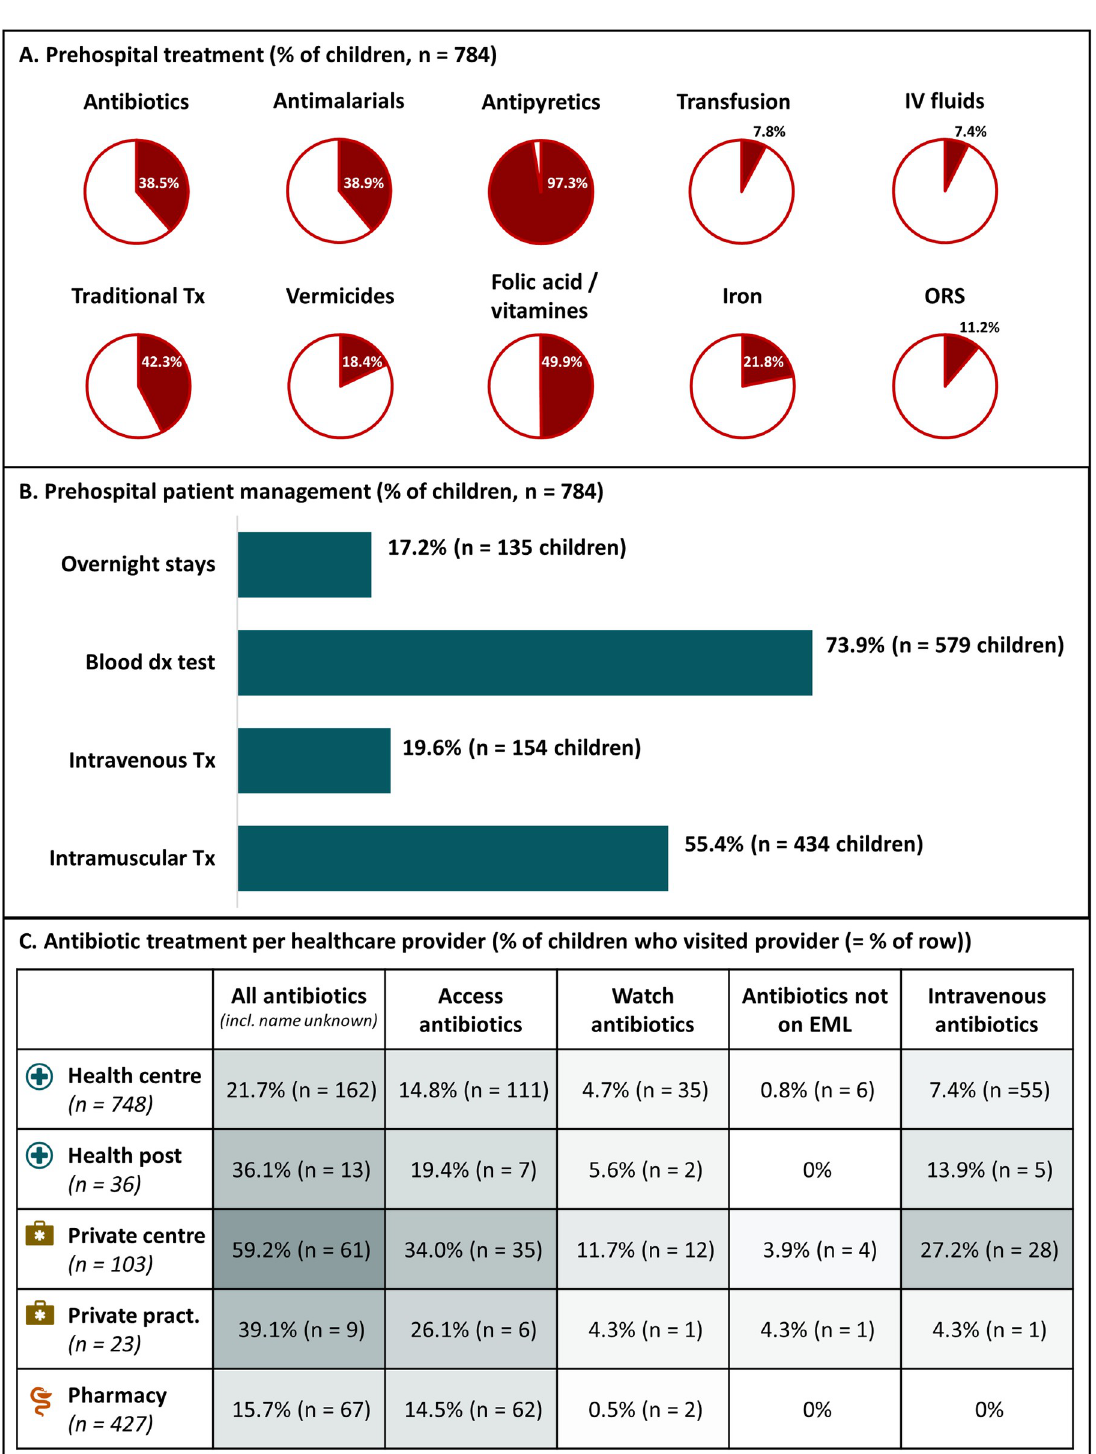
PLOS NeglectedTropical Diseases | https://doi.org/10.1371/journal.pntd.0011156 March 6,